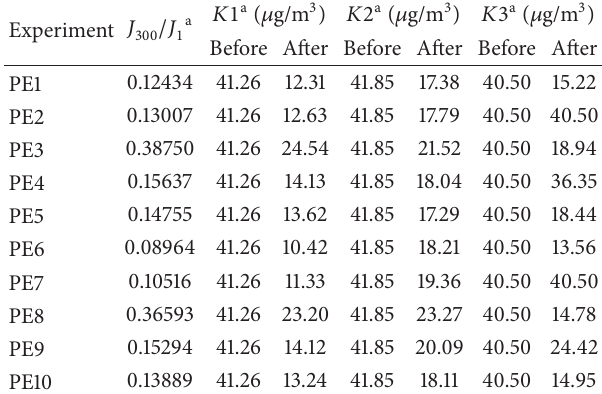
Table 3: Error statistics of practical experiments before and after assimilation.